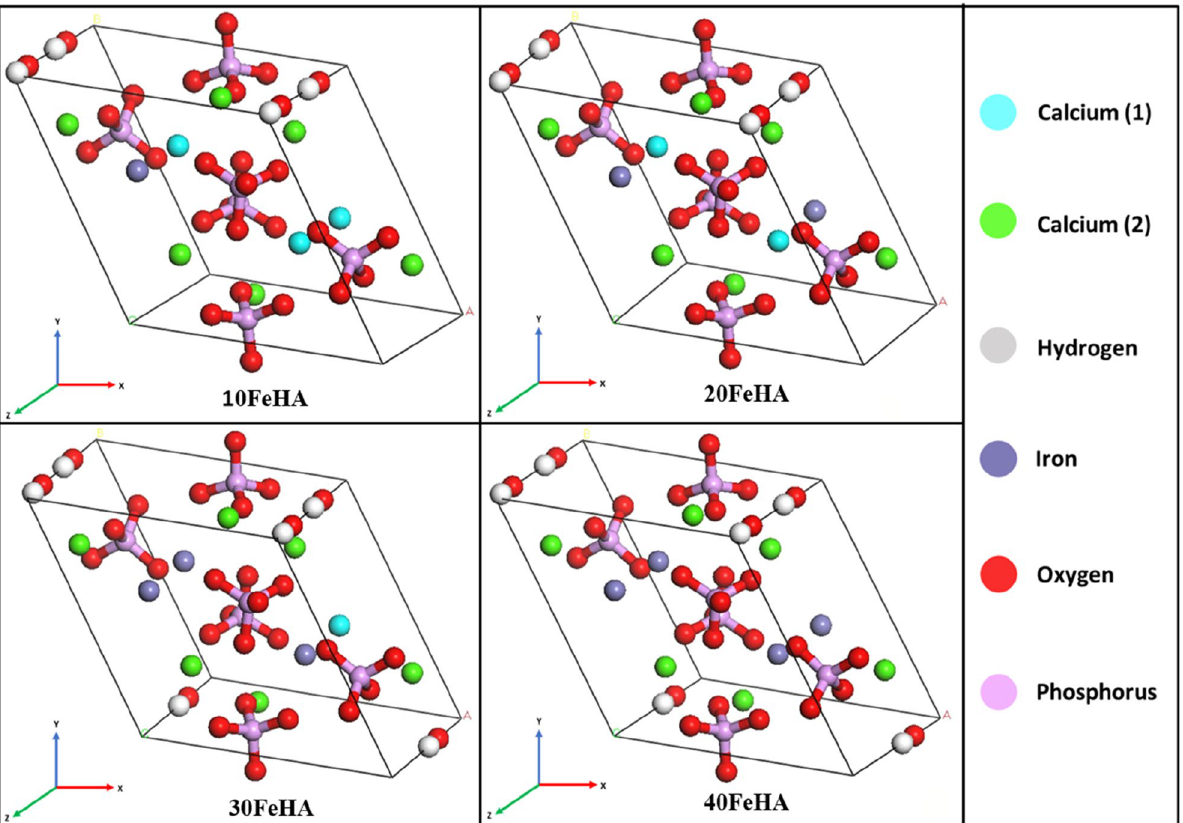
Figure 3. Equilibrated unit cell structure of different Fe-doped HA. 10FeHA, 20FeHA and 30FeHA contain heterogenous atomic columns along ‘ c ’ axis, where Ca 2+ and Fe 2+ reside adjacent to each other. (Sample designation: xFeHA means x mol% Fe 2+ -doped